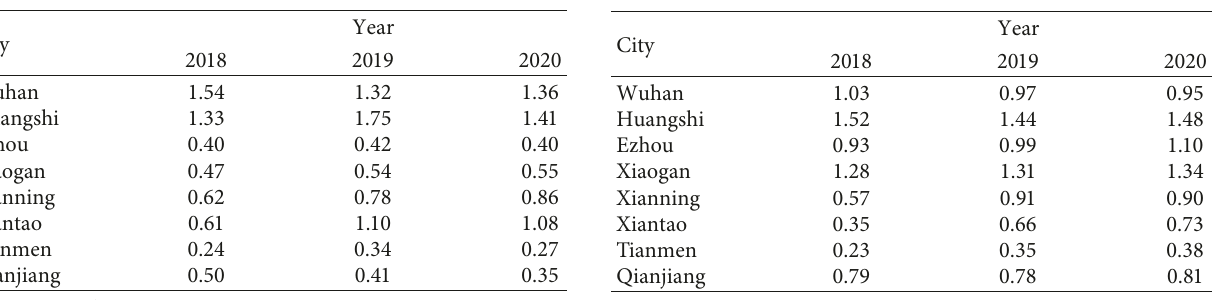
Table 3: Concentration level of capital elements in the Wuhan city